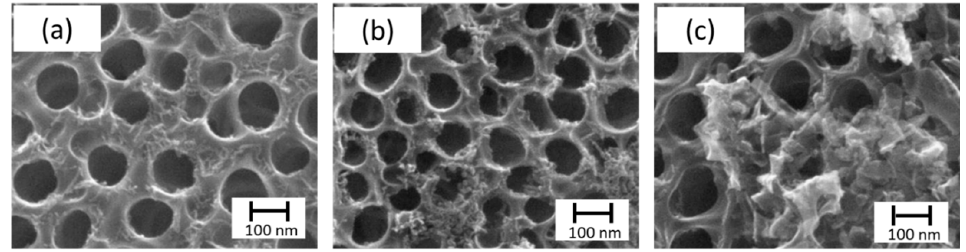
Figure 4. SEM micrographs of SILAR method. Top view of nt-TiO 2 / α -Fe 2 O 3 , namely, ( a ) nt-TiO 2 / α - Fe 2 O 3 (t10), ( b ) nt-TiO 2 / α -Fe 2 O 3 (t60), ( c ) nt-TiO 2 / α -Fe 2 O 3 (t180) with 10, 60, and 180 s, respectively.